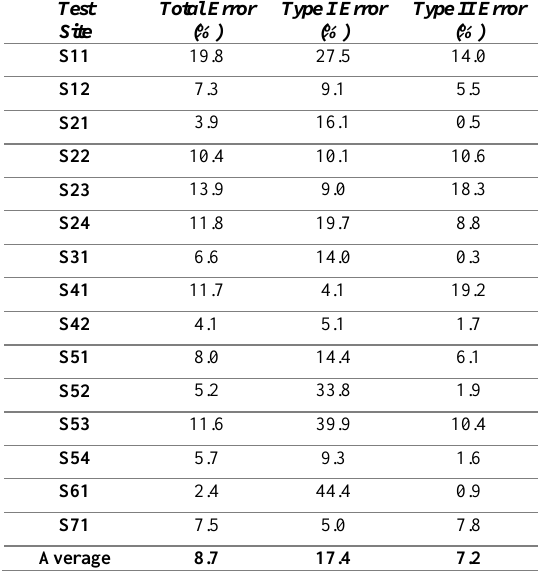
Table 1. Type I, Type II and total errors for the ground filtering of 15 ISPRS test sites